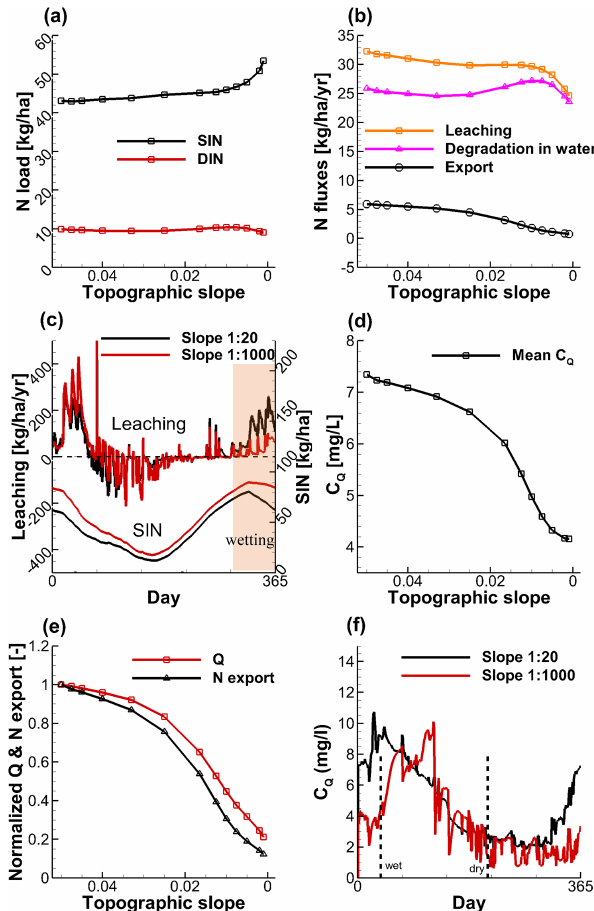
Figure 8. The simulated (a) N loads and (b) N fluxes in relation to the topographic slope for the simulated catchments. (c) Compari- son of the time variable N loads and fluxes between a steep (slope 1 : 20) and a flat landscape (slope 1 : 1000). The simulated (d) flow- weighted mean C Q , and (e) the normalized Q and N export (nor- malized to their values of the base scenario) in relation to the topo- graphic slope. (f) Comparison of the time variable C Q between a steep (slope 1 : 20) and a flat landscape (slope 1 : 1000). Note that for the leaching fluxes in (c) , positive values are referred to as the N leaching from the soil to the groundwater, and negative values are referred to as the precipitation of N from groundwater to the soil by the evapoconcentration effect. The vertical dashed lines indicate the time when the catchment reaches the wettest (left) and the driest (right)